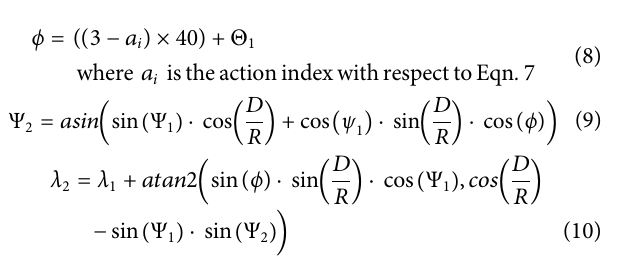
Frontiers in Robotics and AI |